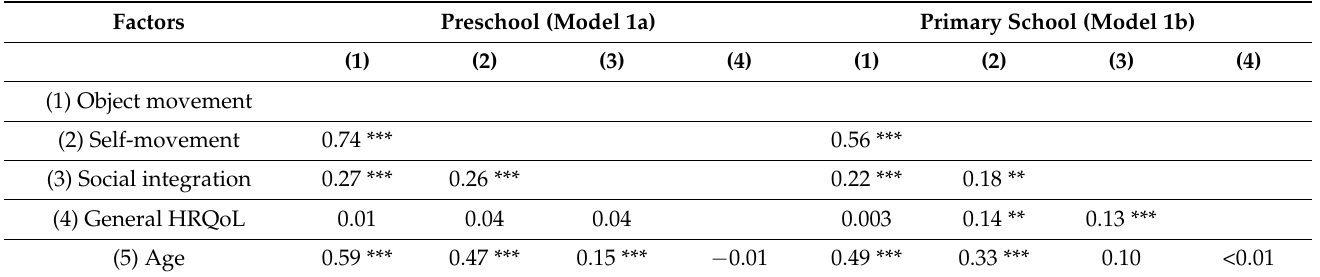
Table 4. Intercorrelations between variables in model 1 (subsample 1).